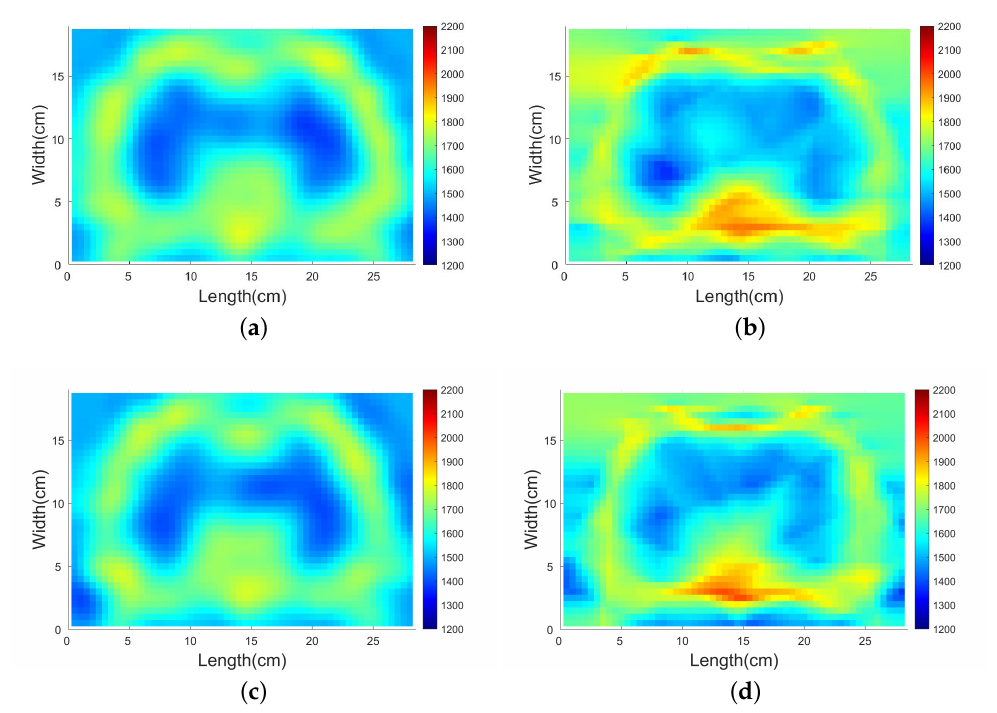
Figure 9. The inversion results of SDM inversion and Gauss–Newton inversion based on different traveltime data. ( a ) SDM inversion based on SPR method traveltime data, ( b ) Gauss–Newton inversion based on SPR method traveltime data, ( c ) SDM inversion based on k-Wave simulation traveltime data, ( d ) Gauss–Newton inversion based on k-Wave simulation traveltime data. Colorbar: 1200–2200 m/s. As a result ( a ), SDM takes 49.9 s to finish the inversion. As a result ( b ), the Gauss– Newton method takes 102.9